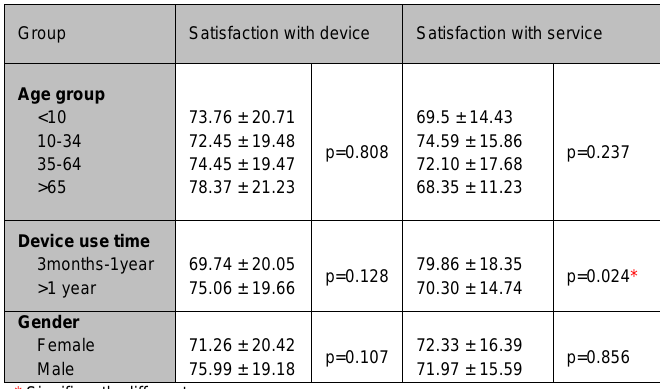
Table 3: Comparison of level of satisfaction with device and with service between and among groups based on gender, age, and device use time.